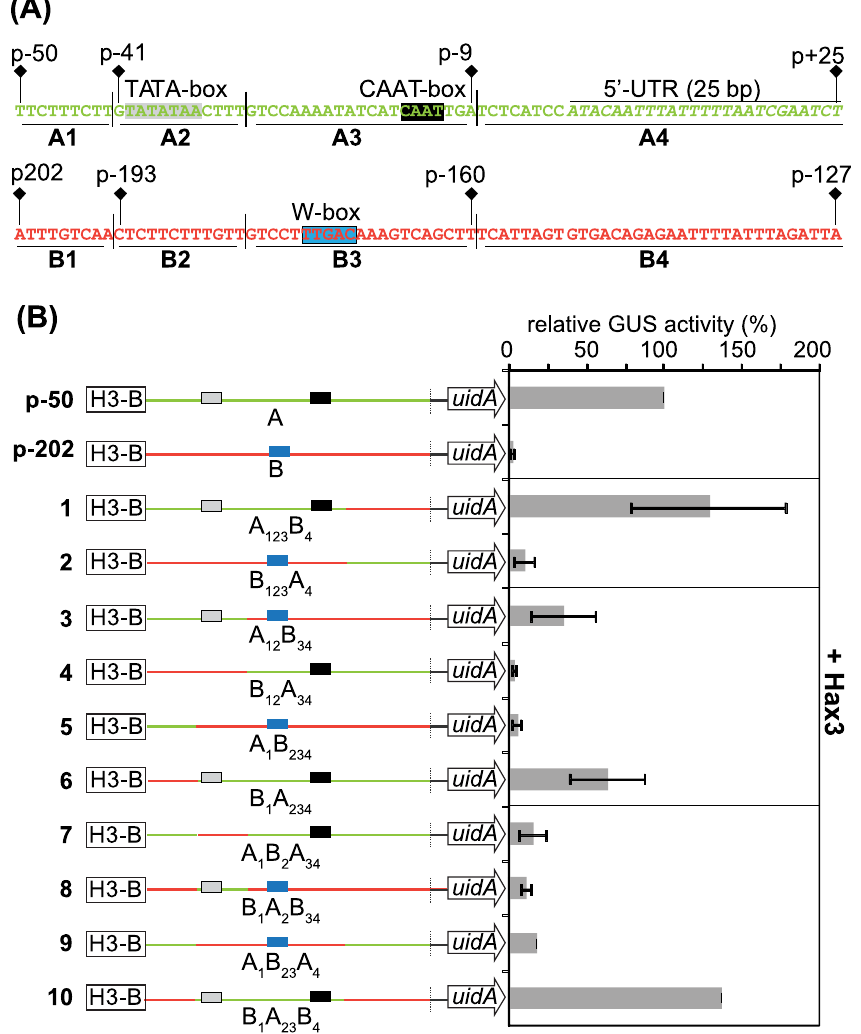
Fig 2. Bs4 promoter swaps to identify regions that support TALE activity. ( A ) The two 75 bp fragments (A, positive, green and B, negative,red) were subdivided into smaller fragments (A1-4, B1-4). Putative promoterelementsthat were predicted [37] are labelledin grey (TATA-box), blue (W-box), black (CAAT-box) or italic and overlined (5´UTR). ( B ) Overview of the analysedpromoter swaps. The origin of the fused fragments is marked with green and A or red and B, respectively.The fragments were placeddownstreamof the Hax3-box(H3-B) and upstream of a promoterless uidA reporter gene. The dashedline indicatesthe locationof the attB1 site precedingthe uidA reporter gene. TALE-dependent activationof the reporter constructs was determinedby β -glucuronidase-measurement. Agrobacterium strains delivering hax3 under control of the 35S promoter were co-inoculated into N . benthamiana leaves along with an Agrobacterium strain deliveringthe respectivereporter construct. The ß-glucuronidase measurement was performed two dpi and calculatedas relative activity basedon the activity of the reference fragment A (100%). Error bars representthe standard deviationof three independentreplicates (4-MU,